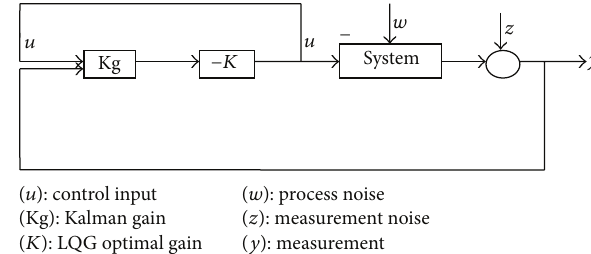
Figure 7: System closed-loop